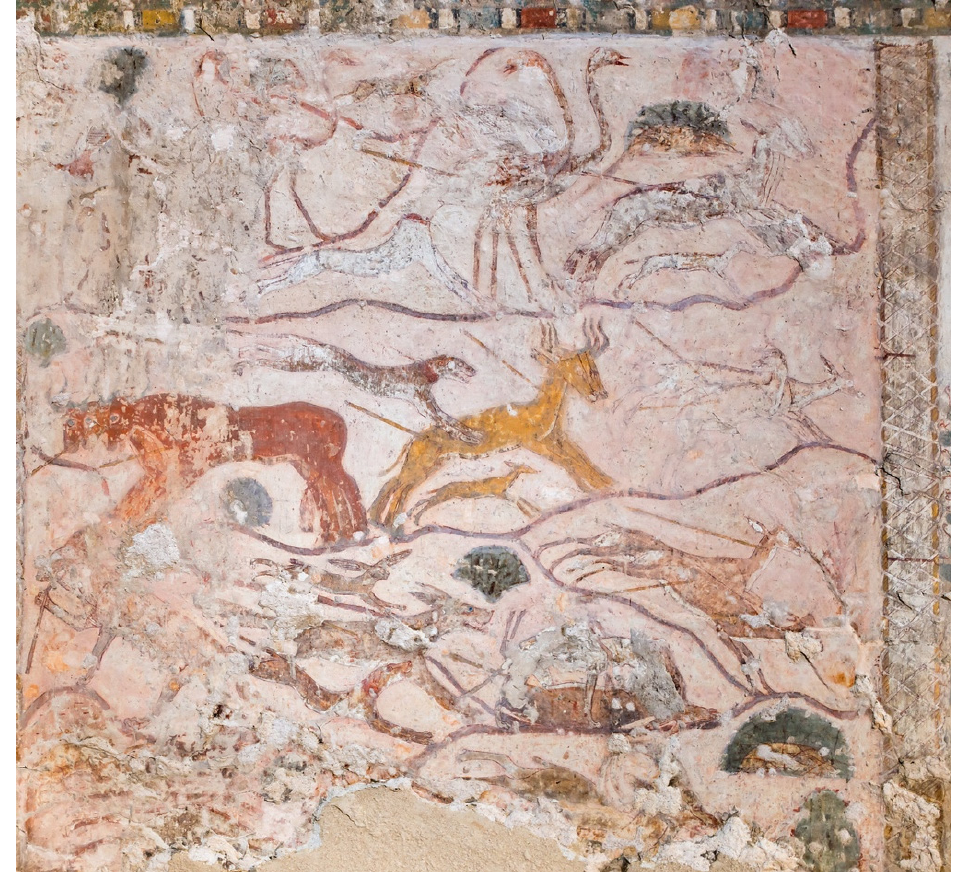
Figure 7. Hunting in the Desert, Tomb of Rekhmire (TT100), Sheikh Abd al-Qurna, Thebes. 18th Dynasty. kairoinfo4u, <flickr.com/photos/manna4u/32312118080> Accessed 21 May 2022.